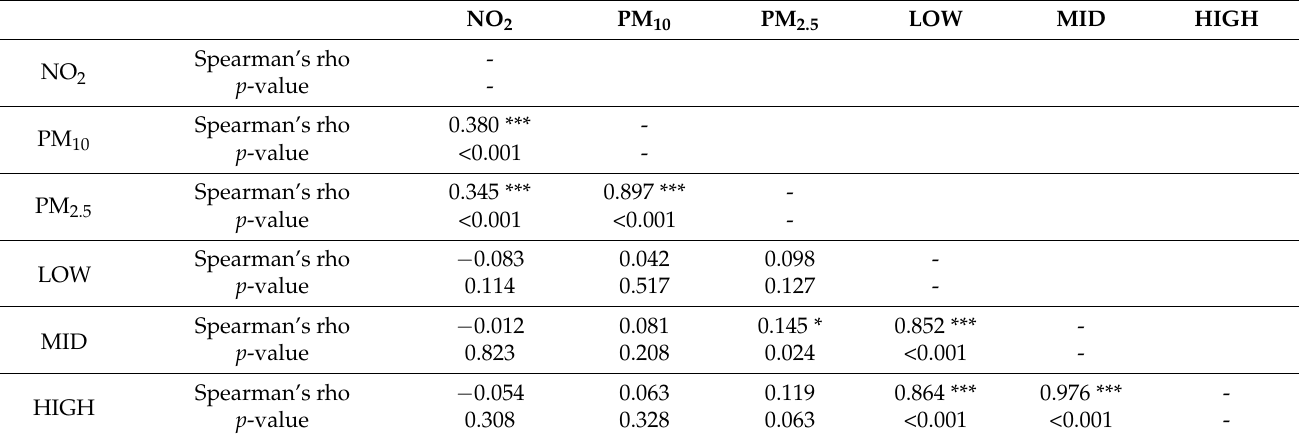
Table 3. Relationship between joint annual average road traffic noise frequency component and concentration of NO 2 , PM 10 and PM 2.5 in all the five monitoring sites. NO 2 PM 10 PM 2.5 LOW MID